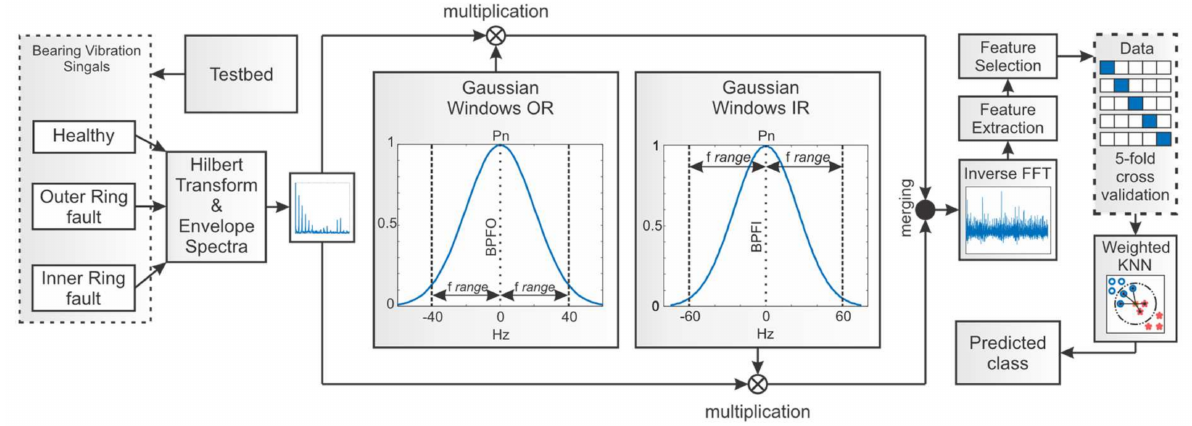
Figure 8. The pipeline of the proposed methodology.